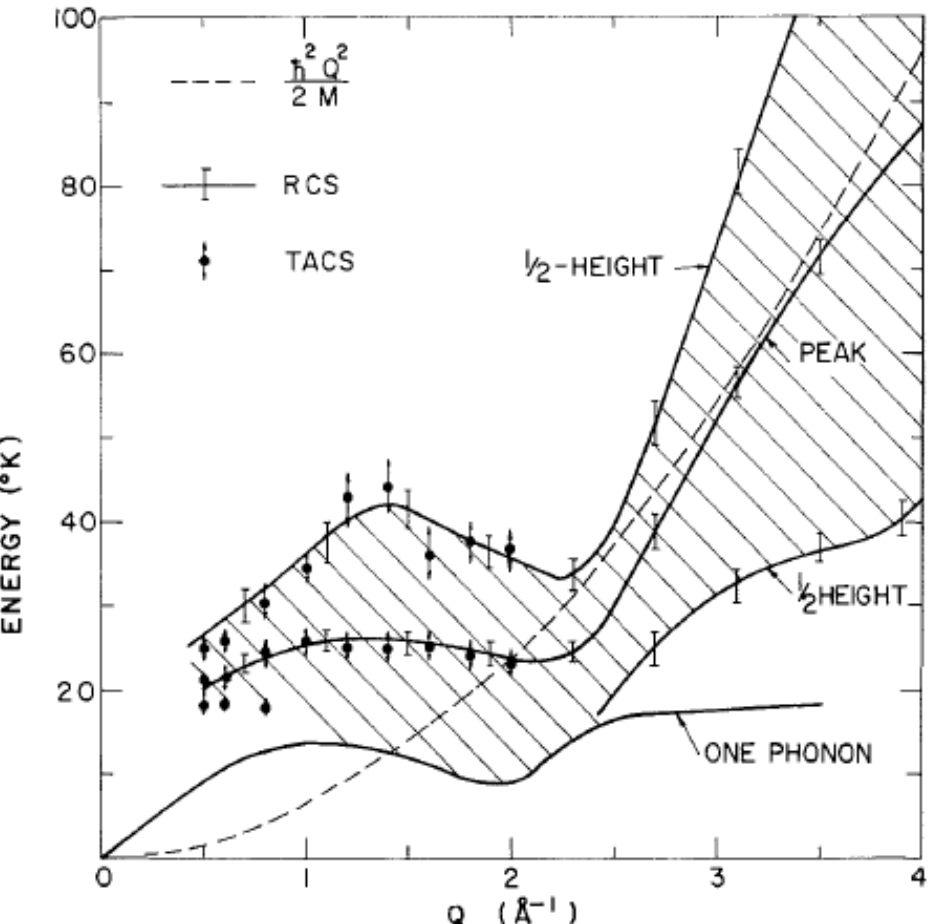
Figure 43. The energy versus wavevector dependence of the scattering at 1.1 K in liquid helium. Shown are the one-phonon dispersion curve, the upper and lower energies corresponding to half peak intensity, and the mean energy of the multiphonon peak. The results were obtained using both the rotating crystal spectrometer and the C5 triple-axis crystal spectrometer. This figure is taken from Figure 6 of ref. [105] courtesy of Canadian Science Publishing and its licensors.